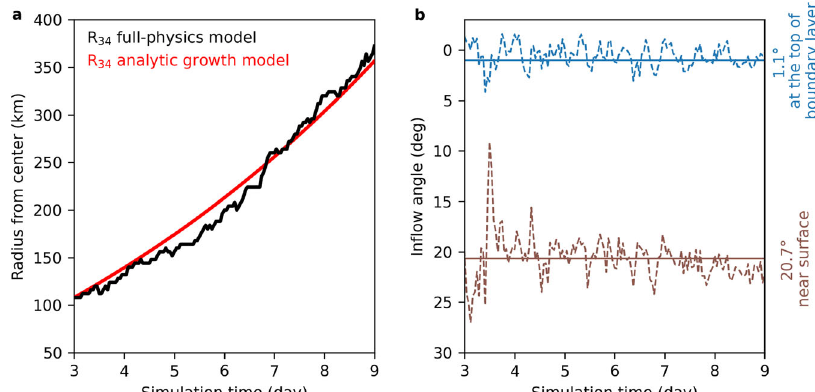
Fig. 1 Time series of outer size and in fl ow angle in the full-physics idealized model. a The growth of outer size ( R 34 ) at a height of 10 m (black line) and the best fi t with the growth model (red line). A wind reduction factor of 0.75 is applied (see “ Methods ” ). b Time series of in fl ow angles at the lowest model level (brown dashed line) and the top of the boundary layer (blue dashed line) following the growing R 34 in ( a ). The in fl ow angles are calculated based on the azimuthally averaged tangential and radial winds. The solid lines show the mean in fl ow angles. The mean effective in fl ow angle during this growth event is estimated to be 1.1° at the top of the boundary